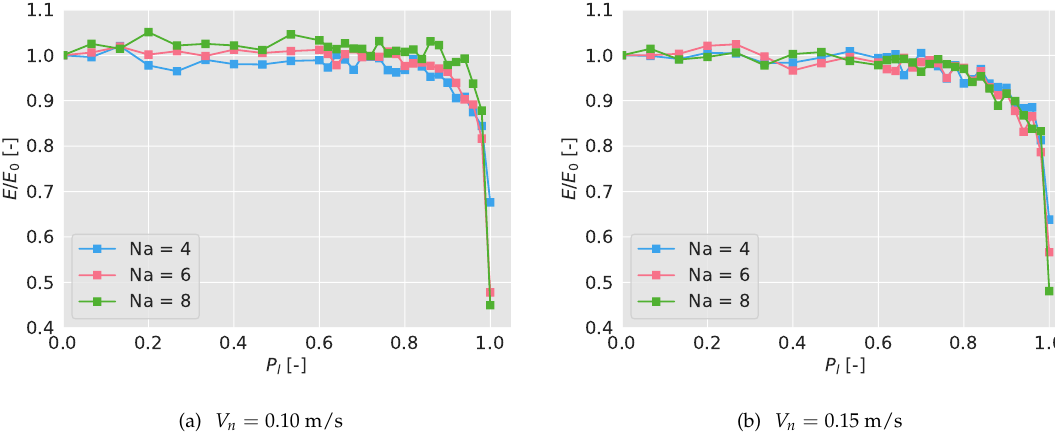
Figure 7. Efficiency of the algorithm depending on the probability of losing a broadcast efficiency, normalized with the efficiency with no lost messages, E 0 . The messages are broadcast at 2